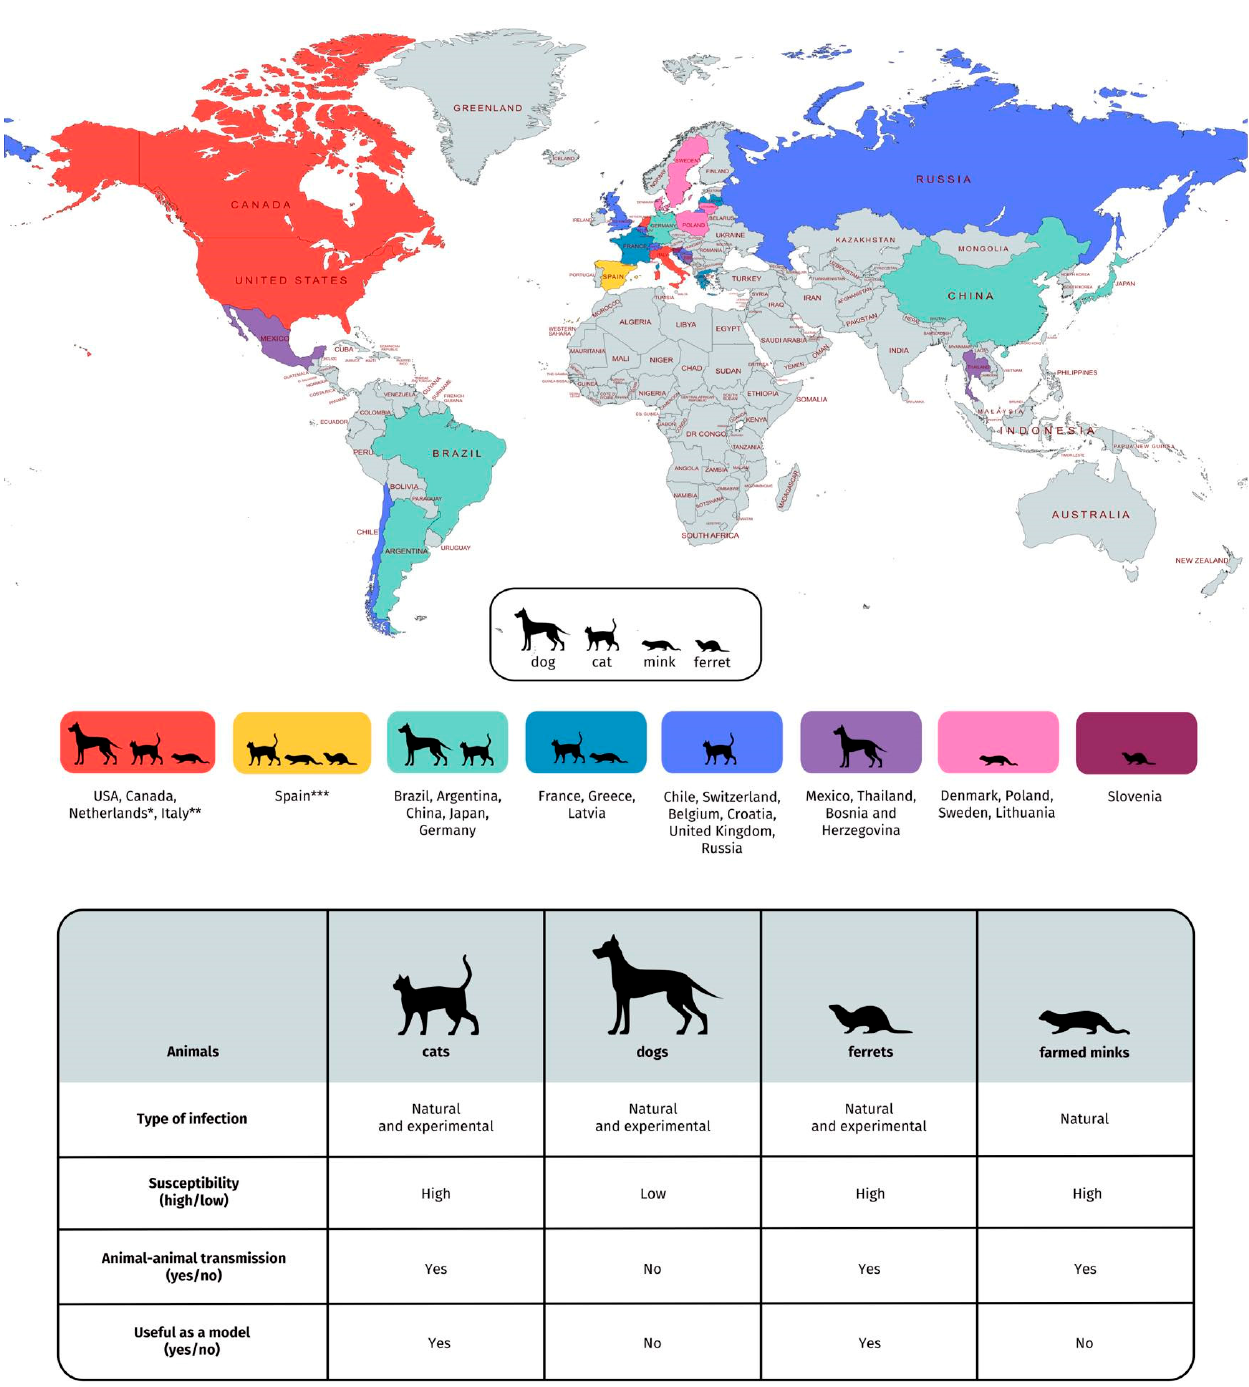
Figure 1. Summary of findings of the SARS-CoV-2 infection in companion animals (including cats, dogs, and ferrets) and farmed minks and reports of SARS-CoV-2 natural infection in these animals (25 May 2021) [19]. * Data of dog and cat isolation in the Netherlands are collected from [30,52]; ** Data of dogs isolation in Italy are collected from [27]; *** Data of pet ferrets isolation in Spain are collected from [63]. We certify that we stays neutral with regard to jurisdictional claims in this map.